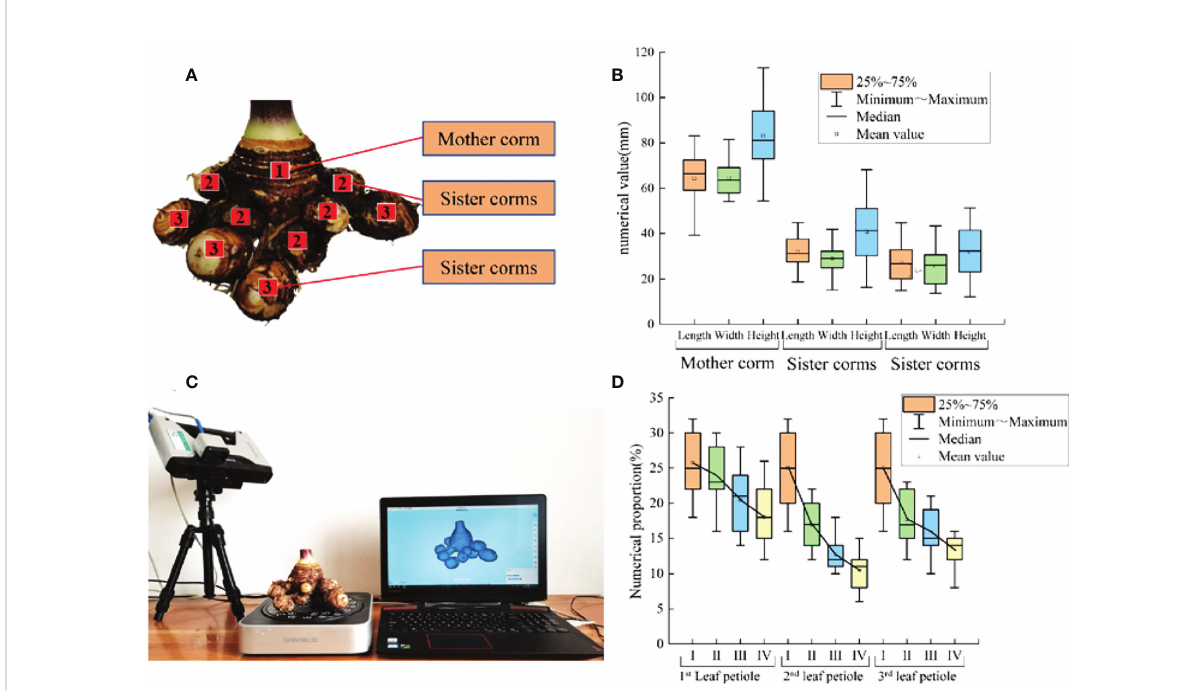
FIGURE 1 Schematic diagram and size statistics of taro corm. (A) The growing position of mother corm, and sister corms; (B) The length, width and height of mother corm, and sister corms statistics; (C) 3D laser scanning experiment of taro corm; (D) The length, width and height of 1st leaf petiole, 2nd leaf petiole and 3rd leaf petiole